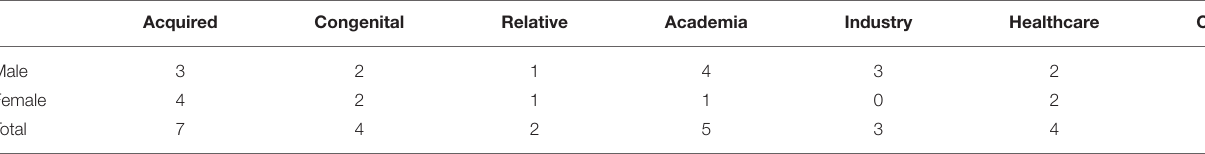
TABLE 1 | Co-creation workshop participants and their affiliations.